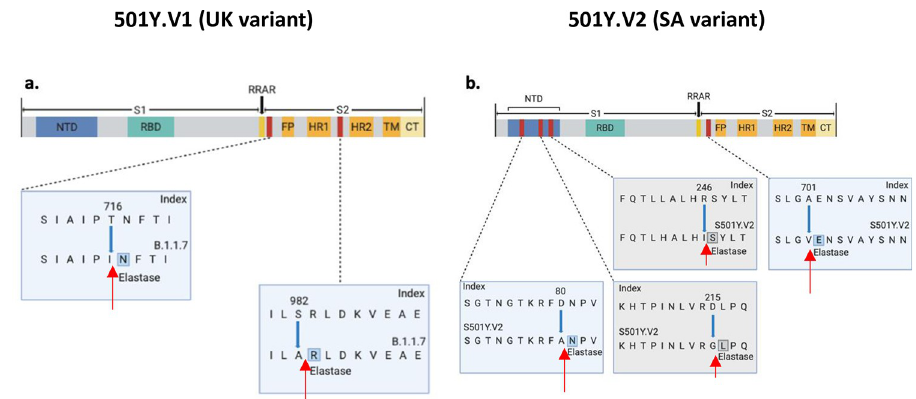
Fig 2. Potential elastase sites in the spike protein of the new SARS-CoV-2 variants. Potential new elastase sites in (a) the more infective UK variant, 501Y.V1 and (b) the more infective South Africa variant, 501Y.V2. Images generated using BioRender. Blue boxes indicate fixed mutations and gray boxes–non-fixed in all the sequenced 501Y. V2 [14]. Red arrows indicate the predicted cleavage site of neutrophil elastase.